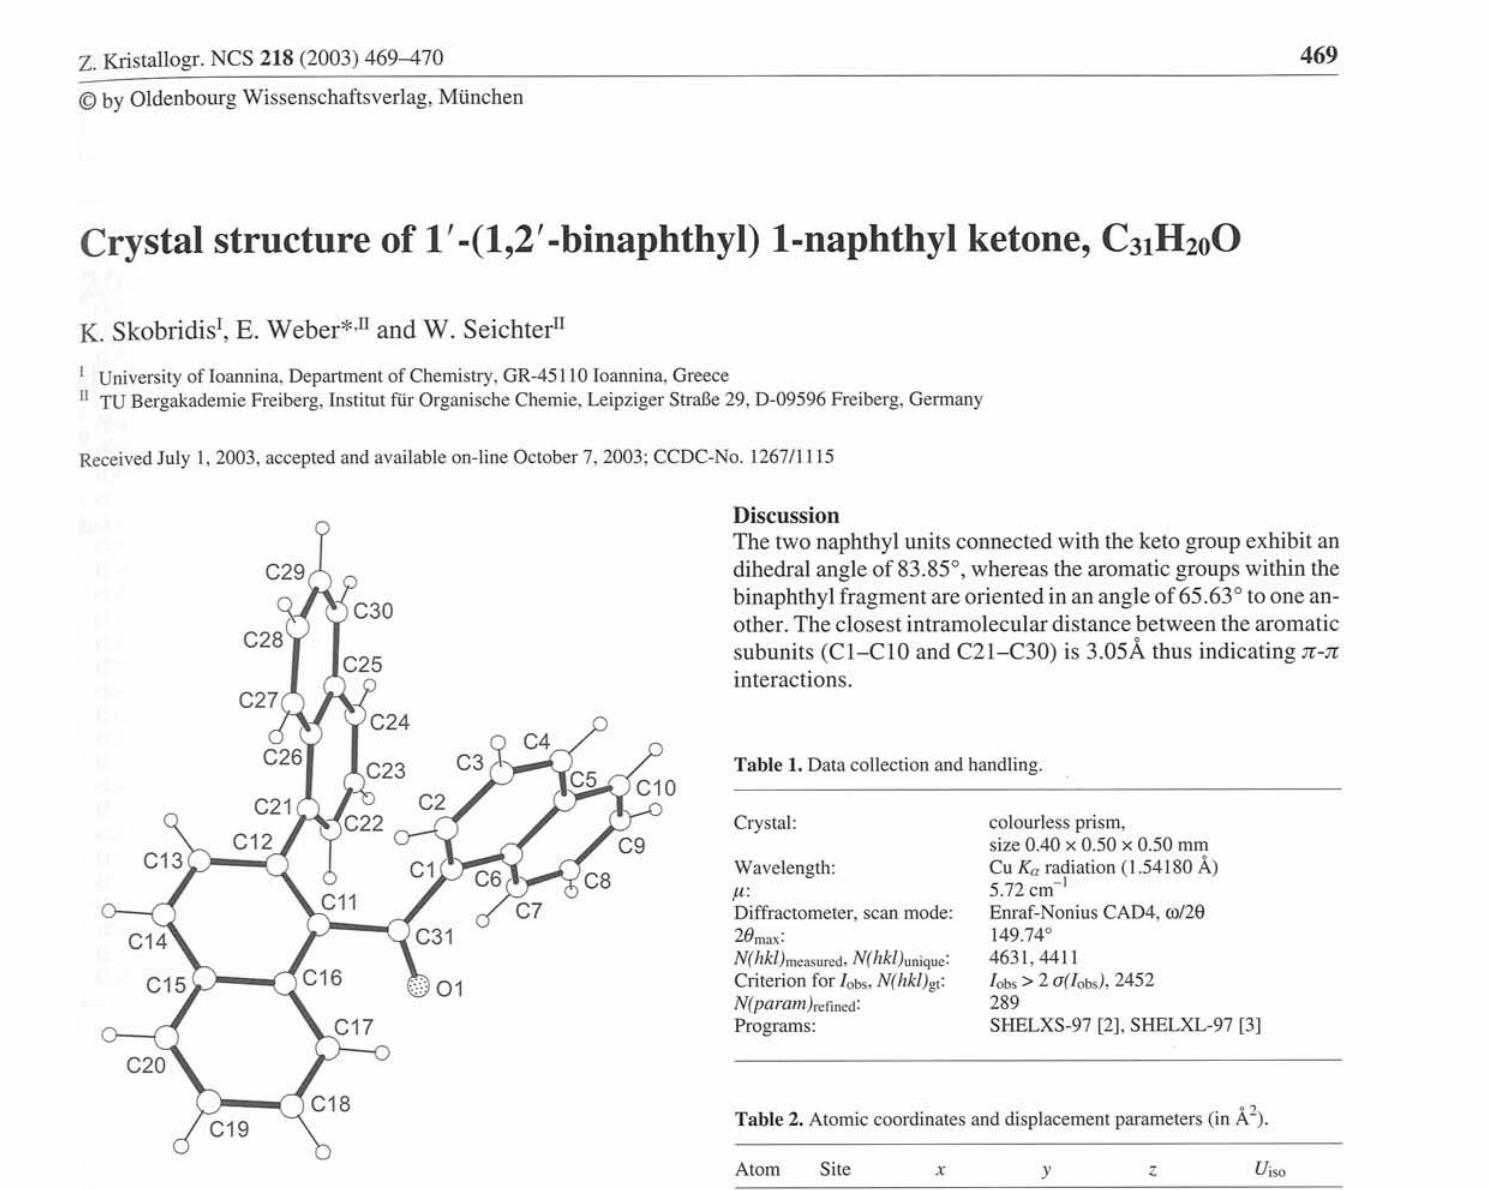
Table 2. Atomic coordinates and displacement parameters (in À